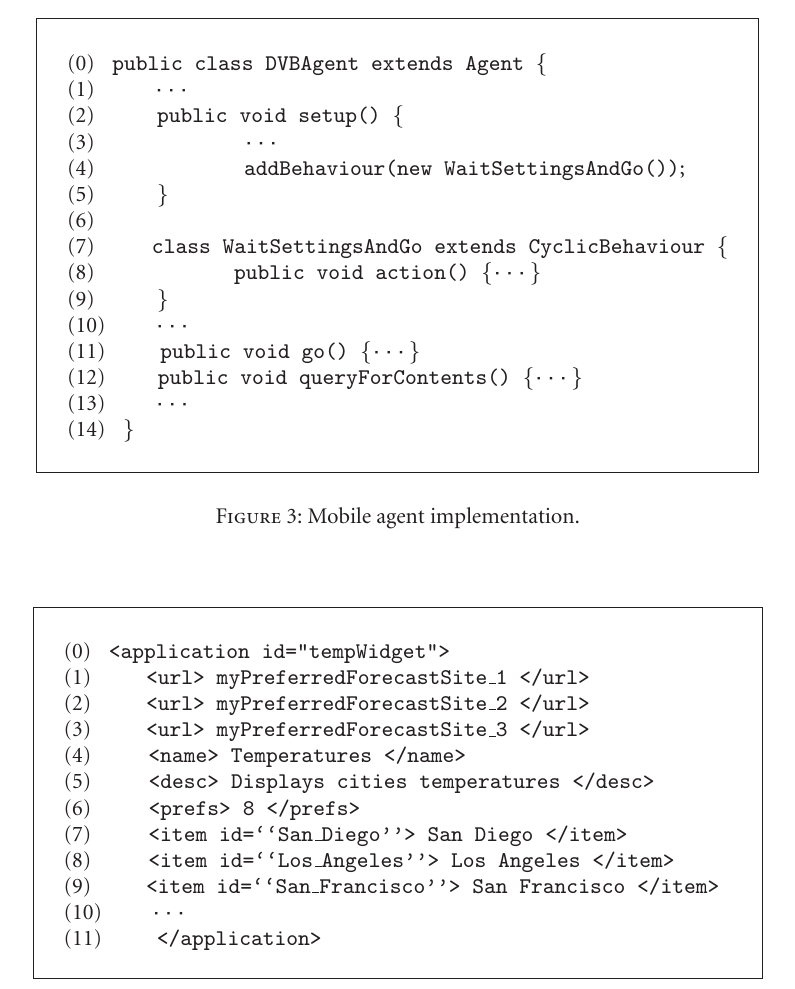
Figure 4: User preferences